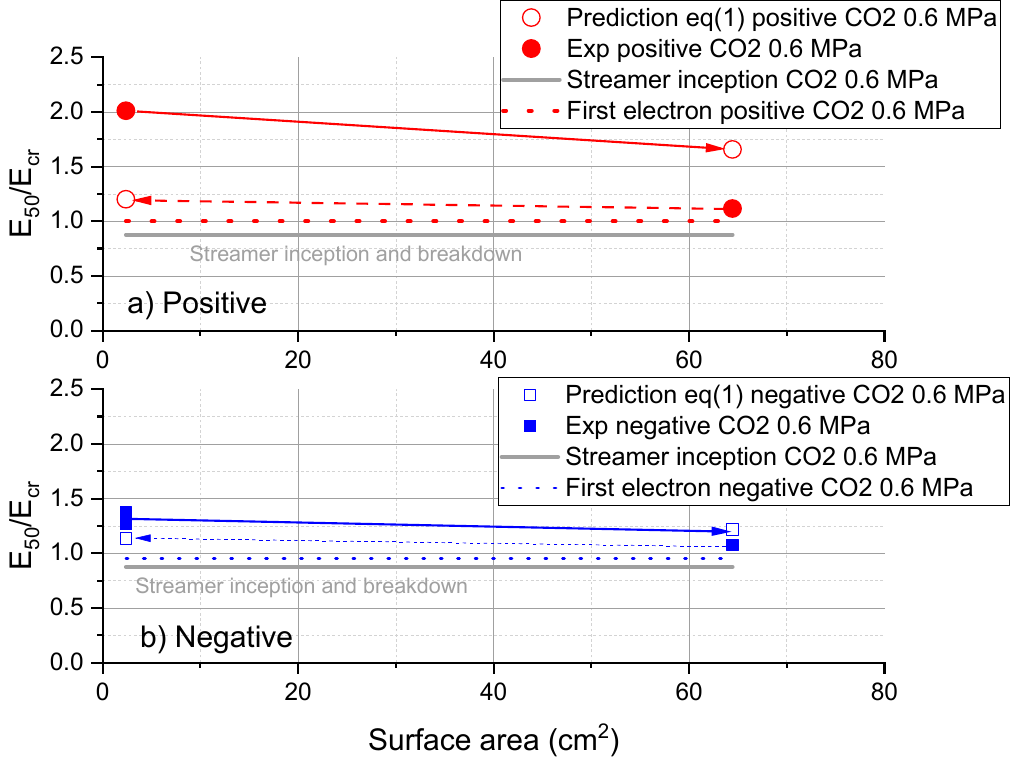
Figure 15. Normalized breakdown fields E 50 / E cr vs. effective surface area in CO 2 at 0.6 MPa at ( a ) positive and ( b ) negative polarities. Calculations for first electron, streamer inception and breakdown at a single hemispherical protrusion of 20 μ m height are shown for comparison.